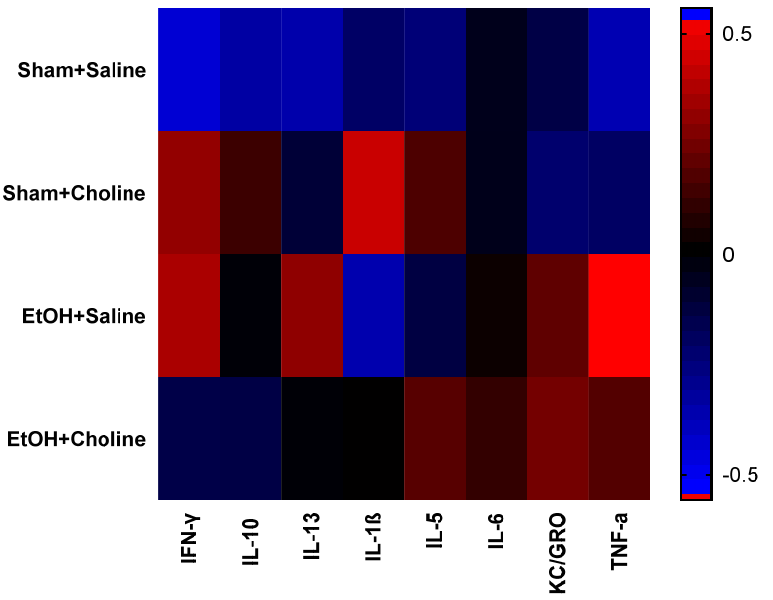
Figure 6. Change in hippocampal cytokine profiles across ages in each treatment group. Heatmaps depicting overall cytokine profiles the difference scores of adult cytokine levels compared to adolescent cytokines levels. Rows represent groups, as indicated, and the columns represent mean cytokine levels (z-scored data) for each group. Colors demonstrate deviations from the mean of zero, as indicated in the color key. EtOH: Ethanol.